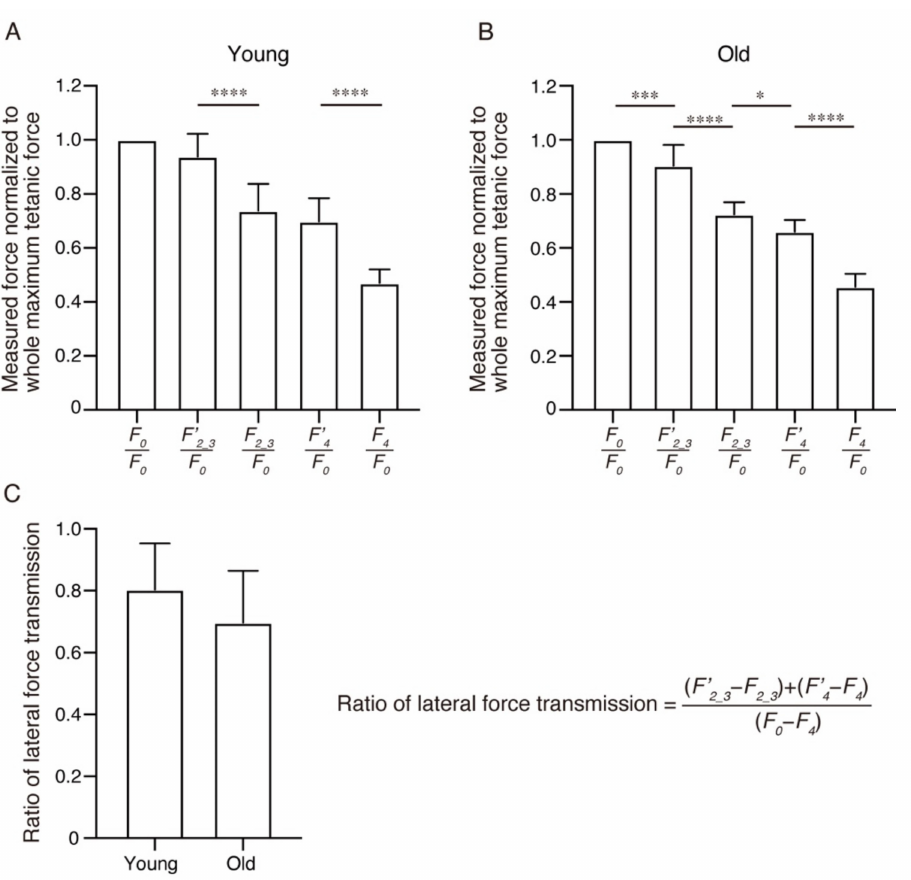
Figure 3. The measured force during a series of tenotomy and myotomy and total contributing ratio of lateral force transmission. ( A ) The force generated in each step in young mice was measured. The measured force was normalized to the maximum tetanic force of the whole extensor digitorum longus (EDL) muscle ( F 0 ). ( B ) The force generated in each step in old mice was measured. The measured force was normalized to the maximum tetanic force of the whole EDL muscle ( F 0 ). ( C ) The contributing ratio of lateral force transmission in total force transmission was calculated. The formula for the ratio of lateral force transmission is shown on the right. Data are expressed as means ± standard deviation; ( A , B ) one-way analysis of variance followed by the Holm–Š í d á k test or ( C ) two-sided unpaired t -test. n = 8 mice per group. * p < 0.05, *** p < 0.001, **** p <